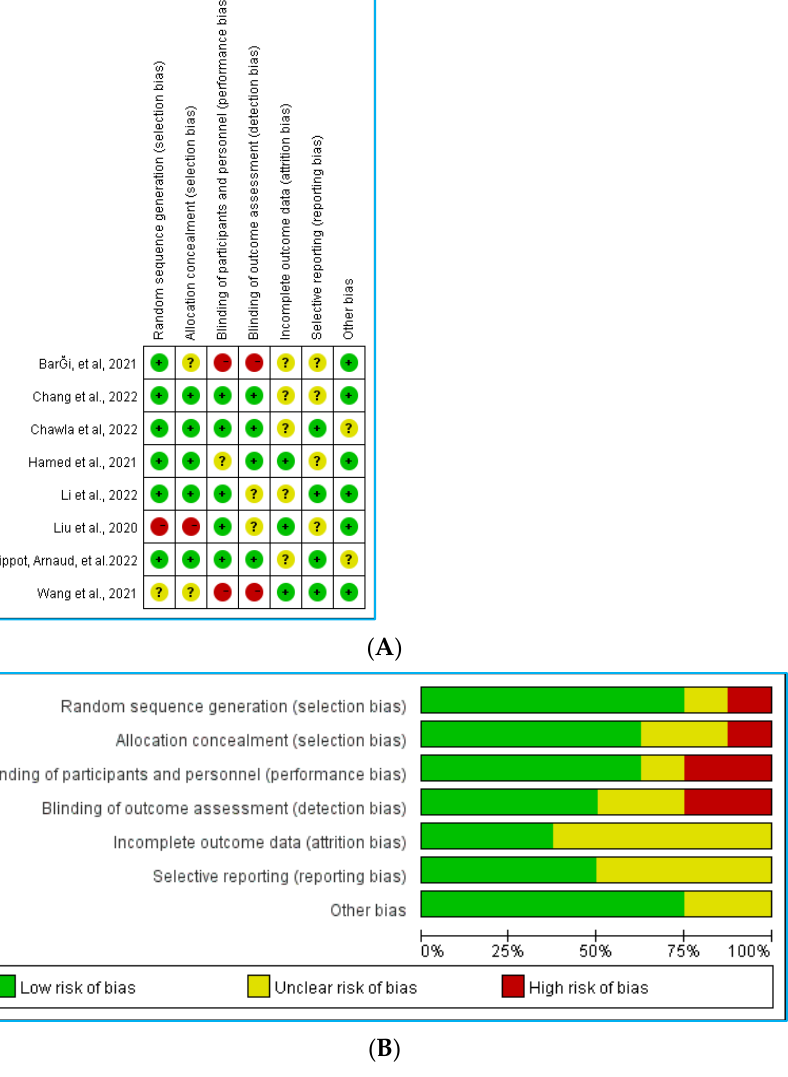
Figure 2. ( A ) Risk of bias ratings. ( B ) Risk of bias graph: percentage of trials receiving low, unclear, or high risk of bias rating for each domain